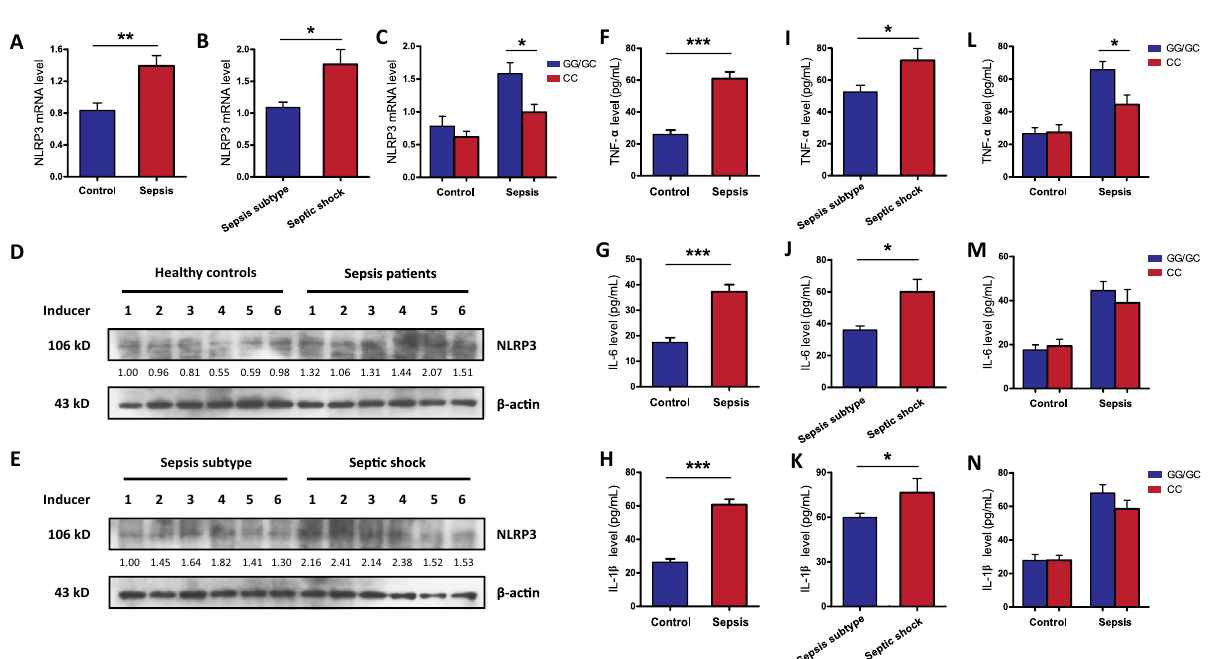
Figure 2. The expression of NLRP3 gene and its downstream inflammatory cytokines in the studied subjects. ( A – C ) The mRNA expression level of NLRP3 in septic patients (n = 50) and healthy controls (n = 50) with different rs10754558 polymorphism; ( D , E ) the production of NLRP3 protein in healthy controls and septic patients were detected by western blot. Full-length blots are presented in the Supplementary Fig. S2; The serum levels of inflammatory cytokines TNF-α ( F ), IL-6 ( G ) and IL-1β ( H ) in sepsis cases and controls; Comparison of serum TNF-α ( I ), IL-6 ( J ) and IL-1β ( K ) levels in different sepsis status (sepsis subject and septic shock); Comparison of serum TNF-α ( L ), IL-6 ( M ) and IL-1β ( N ) levels in subjects with different genotypes at the NLRP3 rs10754558 site. Values of relative expression levels are shown as means ± SEM. * p < 0.05, ** p < 0.01, *** p < tory cytokines. As presented in Fig. 2, sepsis patients exhibited significantly higher expression and production of NLRP3 and the proinflammatory cytokines (TNF-α, IL-6 and IL-1β) than healthy controls, and these levels were significantly increased with sepsis progression. When sepsis cases were separated into subgroups by genotype, carriers of the GG/GC genotypes at the NLRP3 29940G>C site exhibited significantly higher NLRP3 mRNA and TNF-α levels than carriers with the CC genotype. No significant differences in NLRP3 and cytokine levels were found in healthy controls with different genotypes. To further validate whether the NLRP3 29940G>C polymorphism was likely influence NLRP3 expression at the transcriptional level, qRT-PCR analysis was conducted in LPS-stimulated PBMCs from 50 healthy controls to demonstrate the connection between genotype and phenotype. Our results showed that the NLRP3 29940G>C variant was closely associated with the responsiveness of PBMCs to LPS stimulation. LPS stimulation induced significantly higher NLRP3 expression and proinflammatory cytokine (IL-1β and TNF-α) production in PBMCs